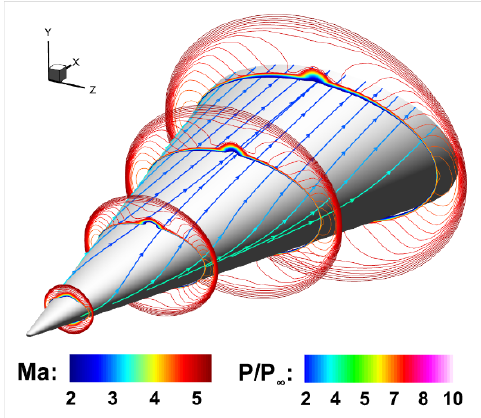
Figure 5. Ma contour and streamlines dyed by P ∞ .